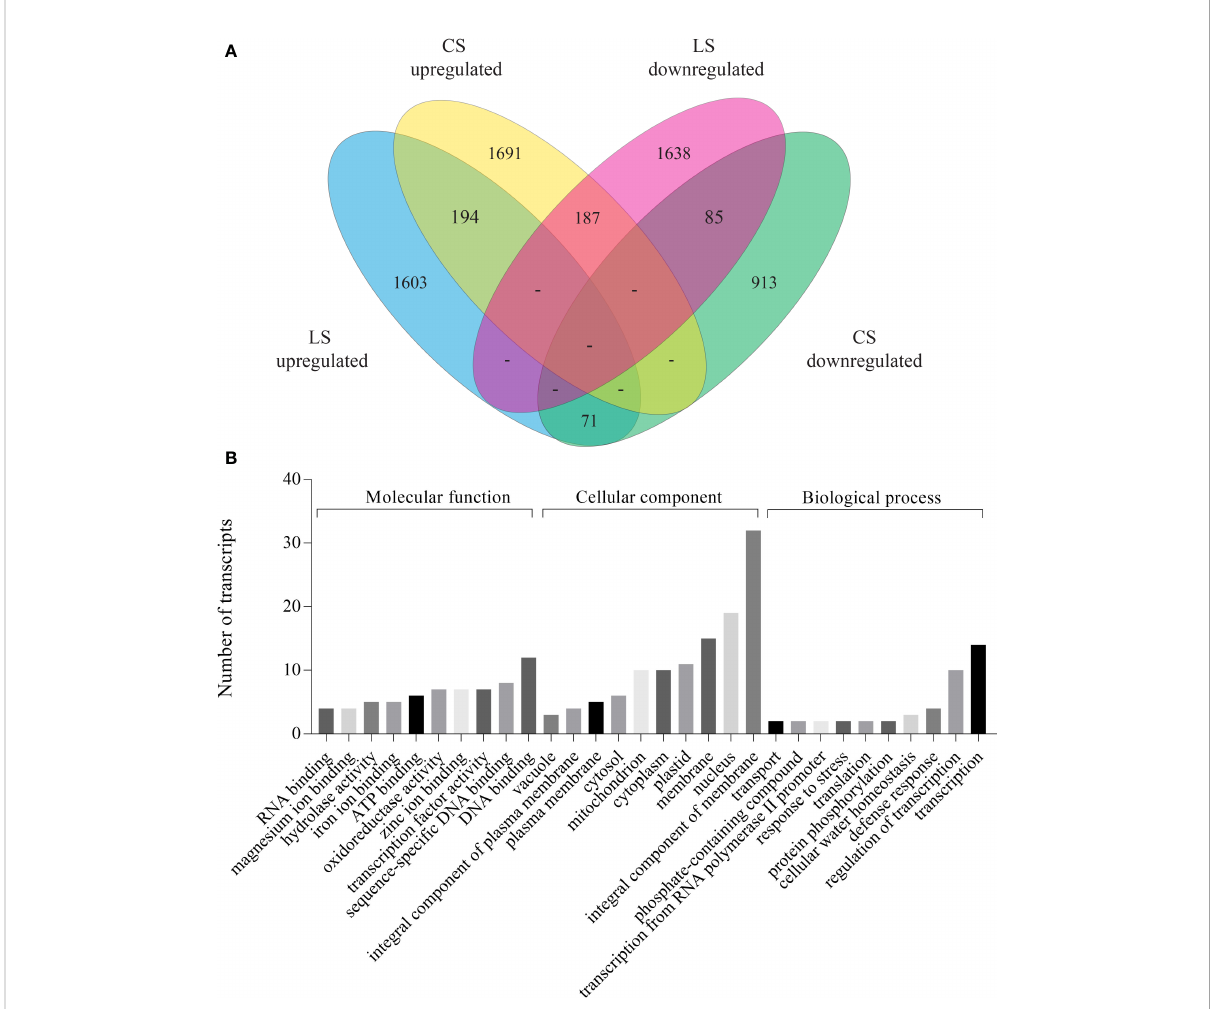
FIGURE 4 Comparison of DEGs identi fi ed in coleoptile senescence with those reported in natural leaf senescence in rice. Leaf senescence data (both second and fl ag leaf) was retrieved (Lee et al., 2017) and was compared with coleoptile senescence dataset obtained in the present study. DEGs identi fi ed in the 36 days post heading (36 DPH) tissues of LS dataset were used for the analysis. (A) Venn diagram of DEGs shows overlap between CS and LS. (B) GO enrichment analysis of DEGs which were commonly upregulated during leaf as well as coleoptile senescence in